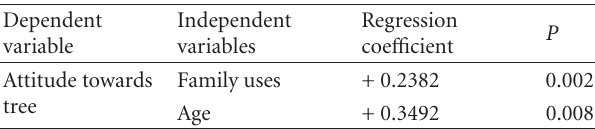
Table 3: E ff ect of age and family uses on attitude towards tree plant-